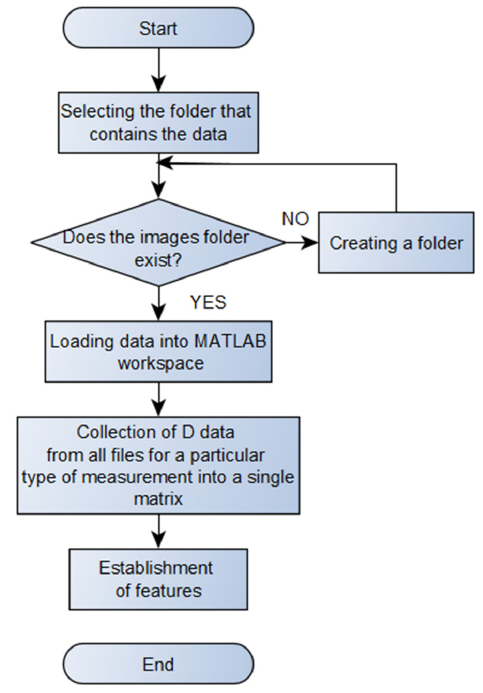
Figure 3. Flowchart of data loading and feature creation .